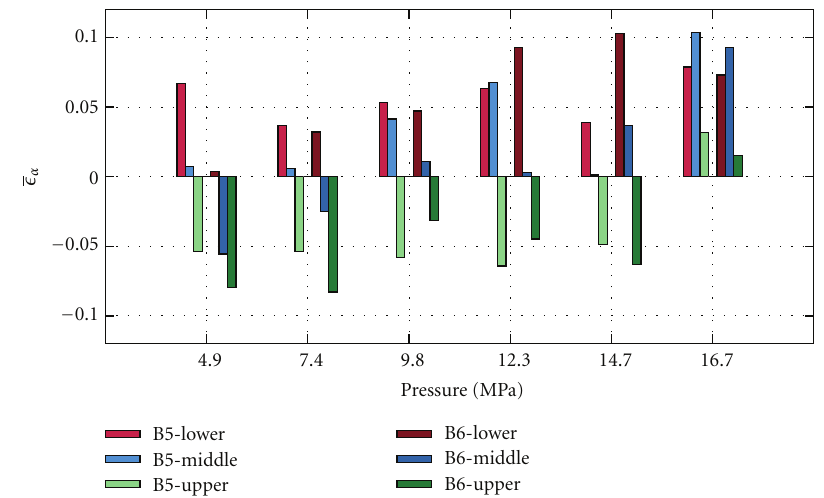
Figure 11: Steady state void fraction error for bundles B5 and B6 arranged by system